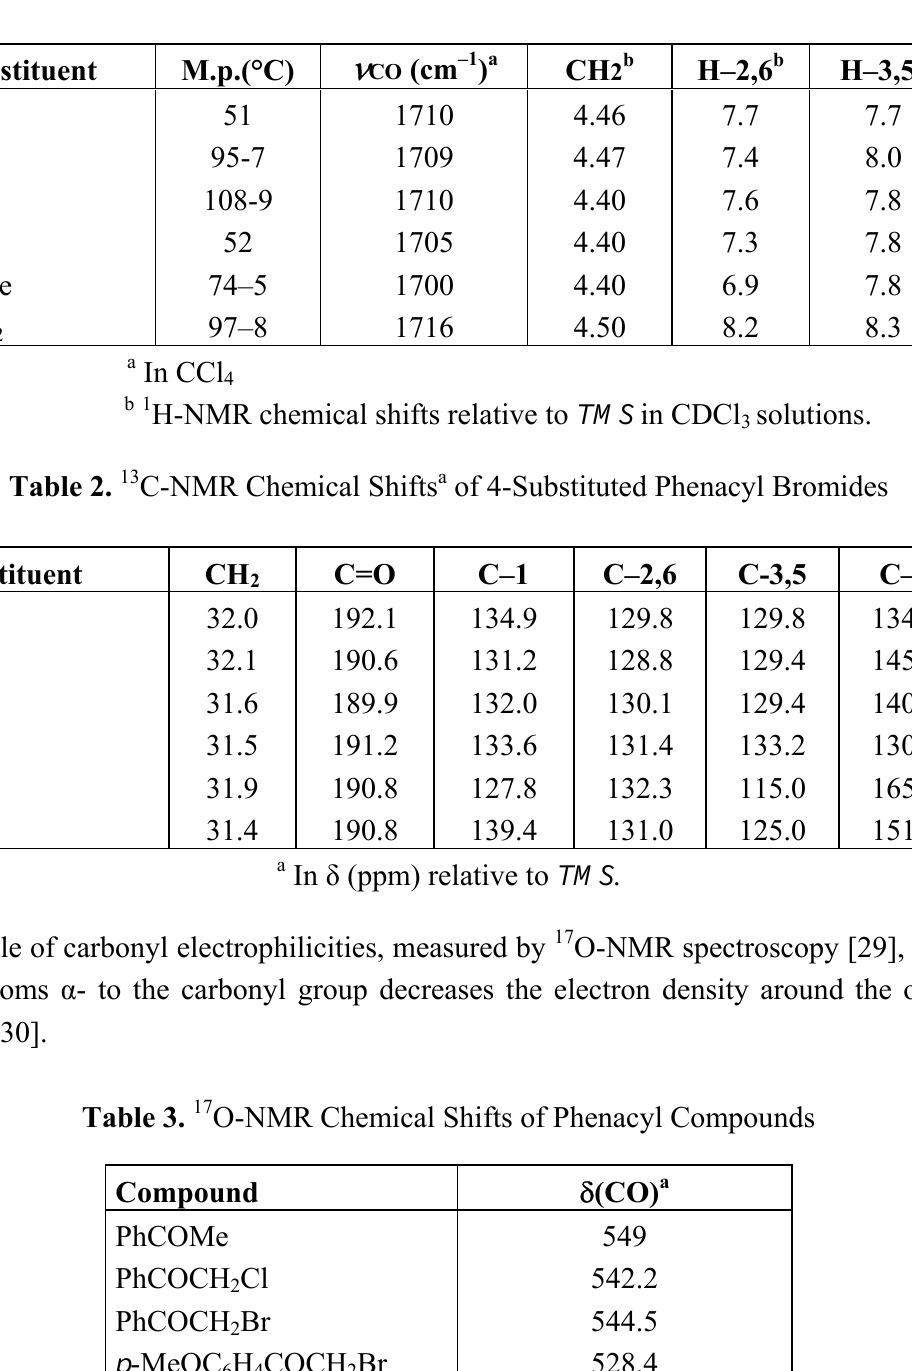
Table 1. Physical and Spectral Data for Some 4-Substituted Phenacyl Bromides